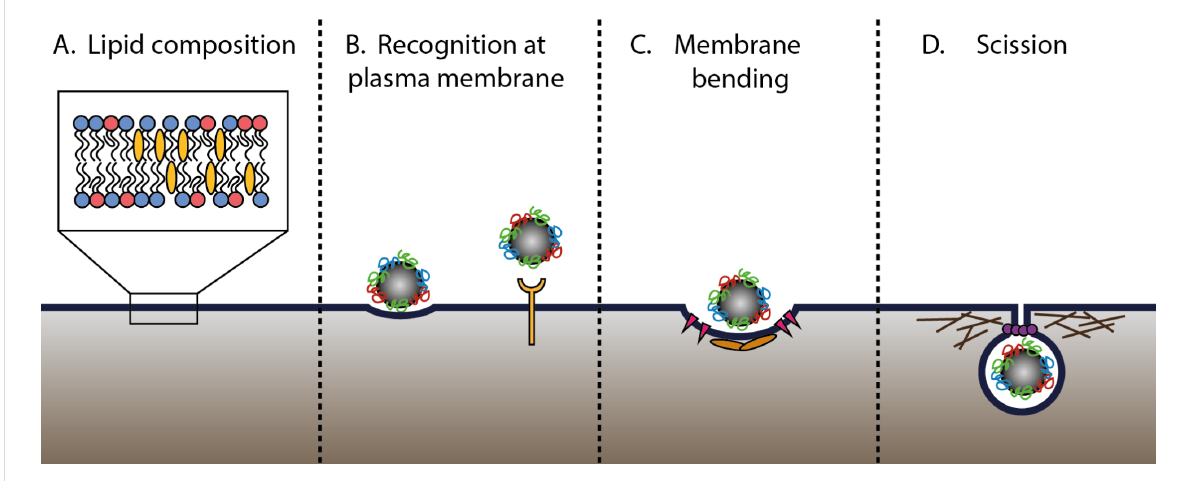
Figure 3: Common features of endocytic pathways [73]. Endocytosis requires a specific cell membrane composition at the site of uptake (A) [72,74- 76] and starts with the recognition of the cargo at the cell membrane (B). Subsequently, membrane bending takes place to form a vesicle (C) [72,73,77,78,84]. Lastly, the vesicle is cleaved from the cell membrane via different mechanisms, which can involve various cellular components (e.g., actin and dynamin, here depicted as lines and circles, respectively) (D)